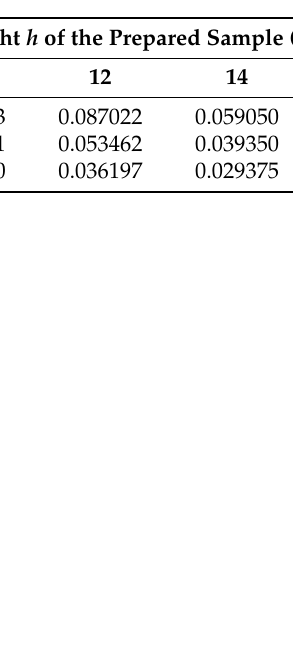
Figure 6. The range of the dry densities of the stratified samples.